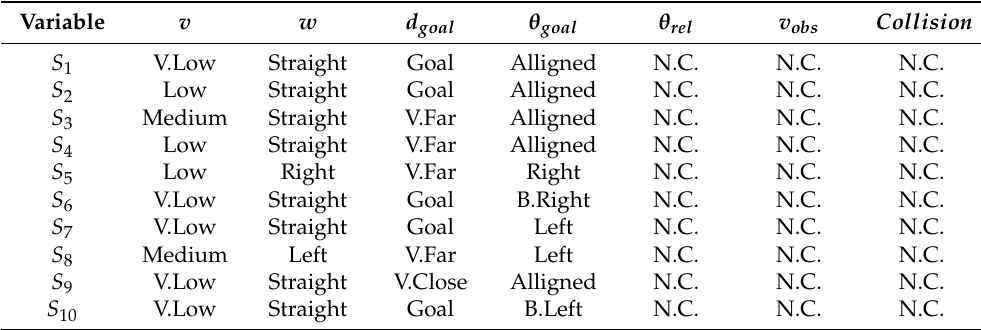
Figure 7. Evolution of the utility of all the states in the RL-DOVS-D system. Table 5. The 10 most valuable states after training the RL-DOVS-D system. V.Far represents the value Very far and N.C. is no